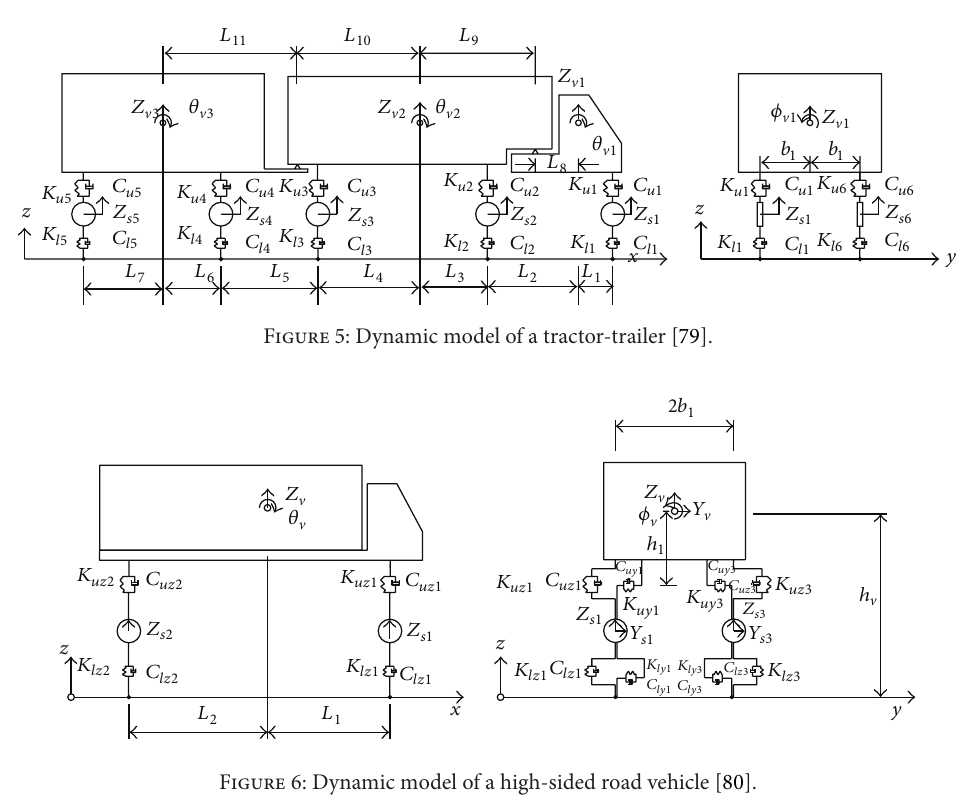
Figure 6: Dynamic model of a high-sided road vehicle